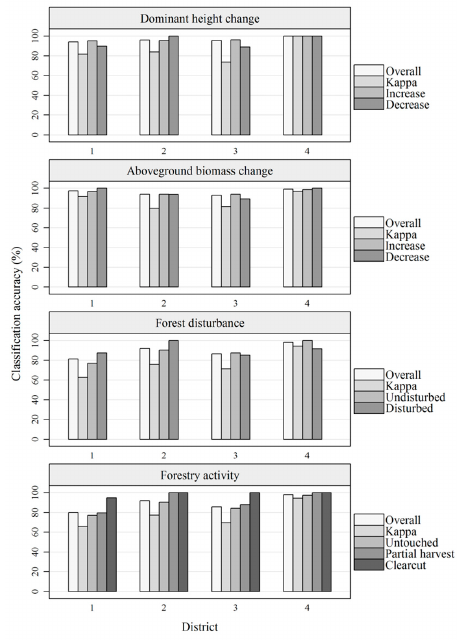
Figure 3. Classification accuracies.